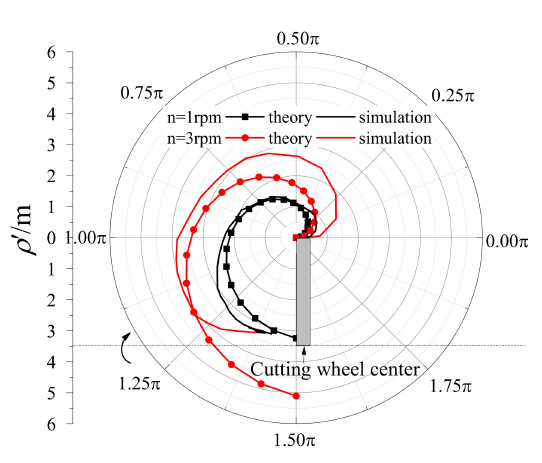
Figure 10. Theoretical and numerical sheared region